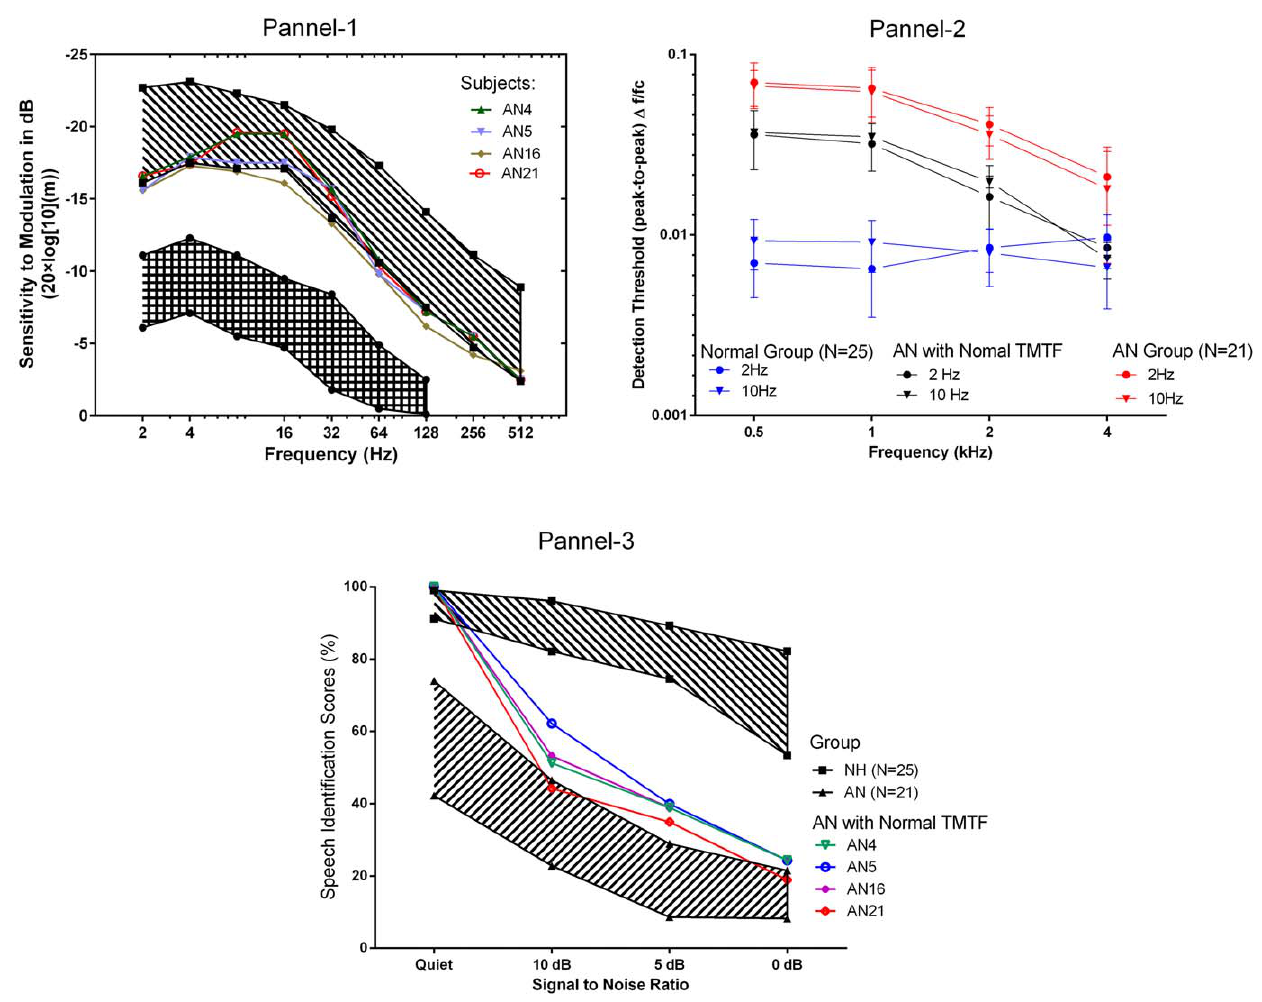
Figure 4. Comparison of data of four exceptional listeners with AN who had normal temporal modulation transfer function (TMTF) and poor perception of speech in noise with the remaining listeners with AN and those with normal hearing. Panel 1: Sensitivity to modulation as a function of modulation frequency. A shaded area with single hatched line for listeners with normal hearing (NH) and double hatched line for listeners with auditory neuropathy (AN). The shaded area indicates 95% confidence interval. Individual data from each of the four listeners with AN is shown with separate symbols. Panel 2: Frequency modulation detection threshold (FMDL)for 2 Hz and 10 Hz expressed as peak-to-peak deviation divided by center frequency and plotted as a function of center frequency. The mean data of the four exceptional listeners with AN is shown separately symbol. Panel 3: Speech perception scores as a function of signal to noise ratio. The shaded area indicates 95% confidence interval. Individual data from each of the four listeners with AN is shown with separate symbols.